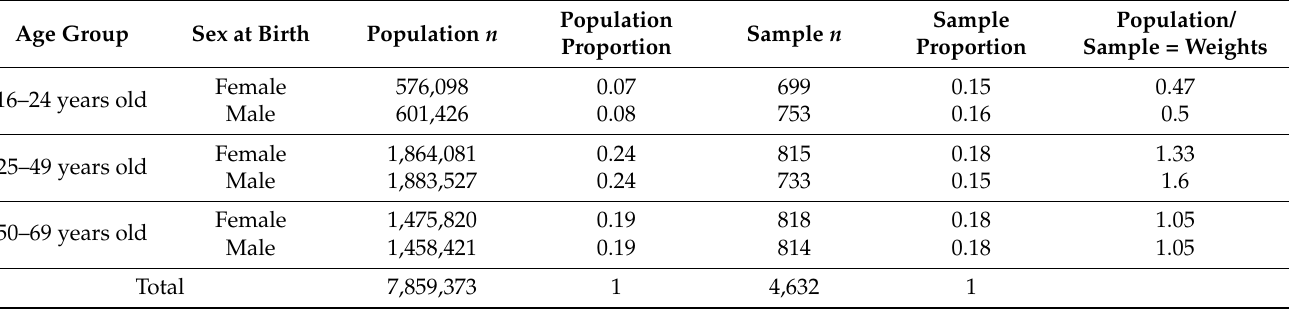
Table 2. Sample weights. A comparison of the gender distribution between the Belgian population and the study sample stratified by